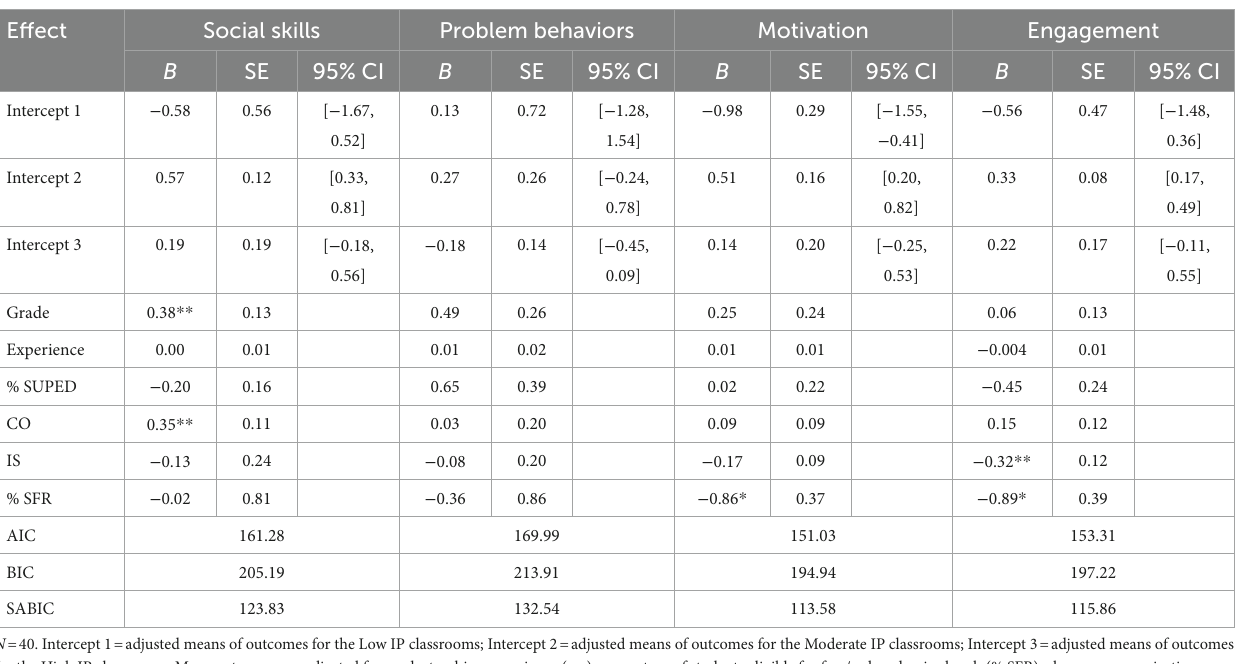
TABLE 5 Common-slope model estimates by outcome variables.